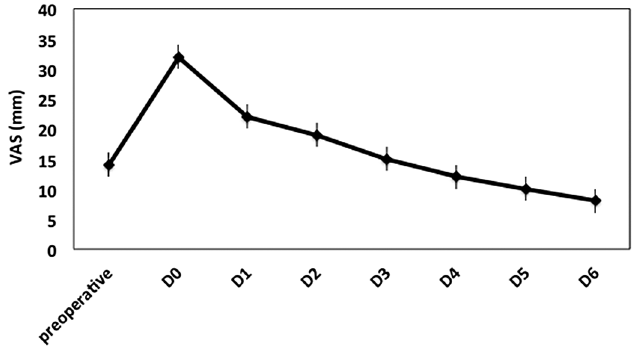
Fig. 1. Pain intensity pro fi le over a 7days period of time [3]. VAS: Visual Analog Scale; D: Day.